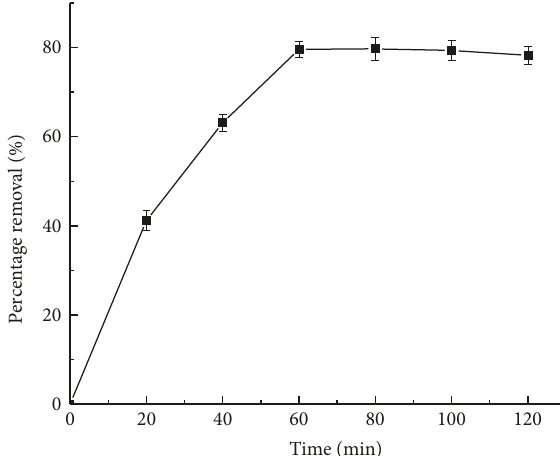
Figure 5: Effect of contact time for Cr(VI) adsorption using hybrid membrane of carboxymethyl chitosan and silicon